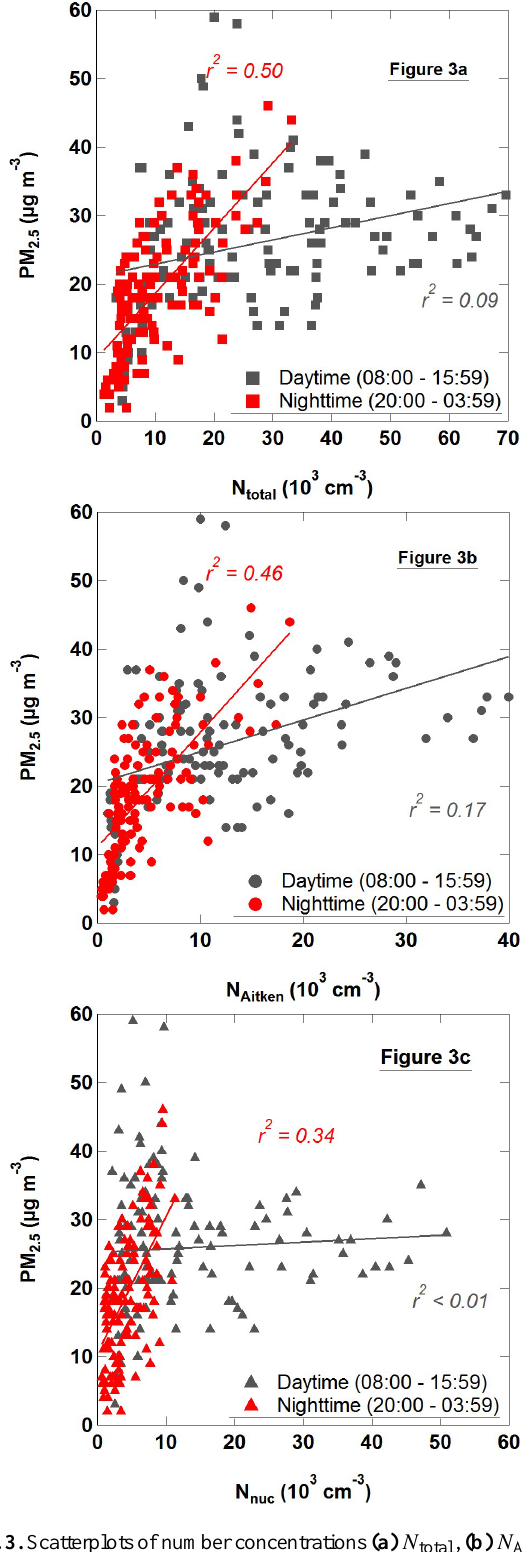
Fig. 3. Scatterplots of number concentrations (a) N total , (b) N Aitken and (c) N nuc against PM 2 . 5 . Nighttime data are highlighted with red symbols, and daytime data are shown in grey symbols.